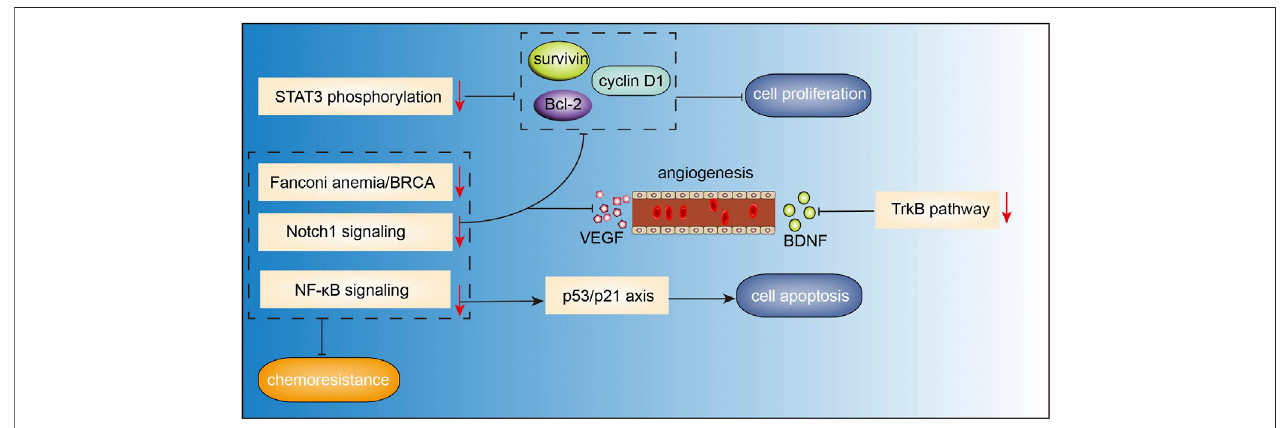
FIGURE 3 | Action pathways involved in the anti-MM effects of curcumin. represents inhibitory effects, represents stimulative